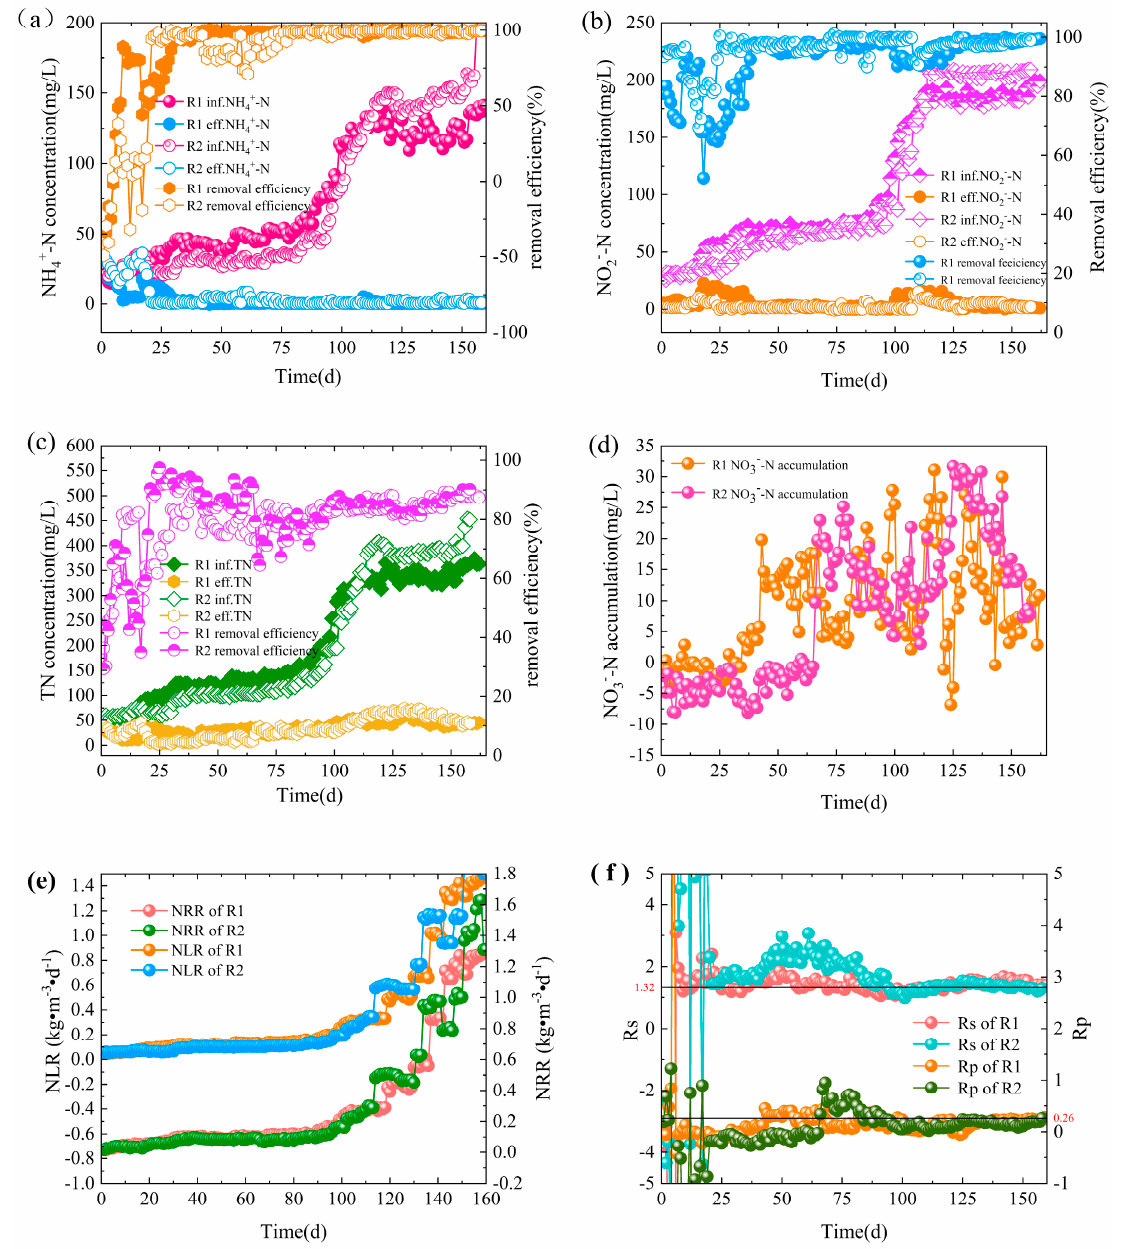
Figure 2. Long-term performance of nitrogen removal in the reactors. Concentrations and removal rates are shown for NH 4+ -N ( a ); NO 2 − -N ( b ); total nitrogen (TN) ( c ); and the Δ NO 3 − -N accumulations ( d ); variations of nitrogen loading rate (NLR) and nitrogen removal rate (NRR) ( e ) and of Rs ( Δ NO 2 − - N/ Δ NH 4+ -N) and Rp ( Δ NO 3 − -N/ Δ NH 4+ -N) ( f ). ( ∆ NO − -N/ ∆ NH 4+ -N) and Rp ( ∆ NO − -N/ ∆ NH 4+ -N) ( f 2 3